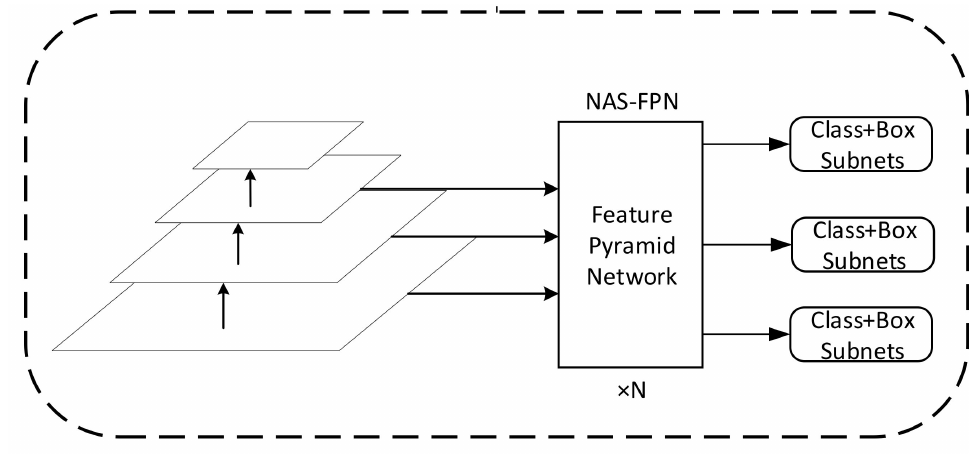
Figure 4. The NAS-FPN RetinaNet. N is the number of module repetitions.